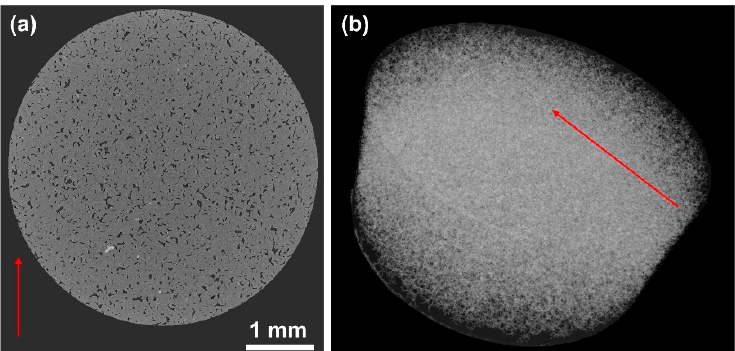
Figure 4. X-Ray Computed Tomography. ( a ) 2-dimensional (2d) and ( b ) 3-dimensional (3d) recreation of the porous Mg-Zn-Zr scaffold manufactured via binder jet printing. The red arrows indicate the building direction (stacking direction of the powder).